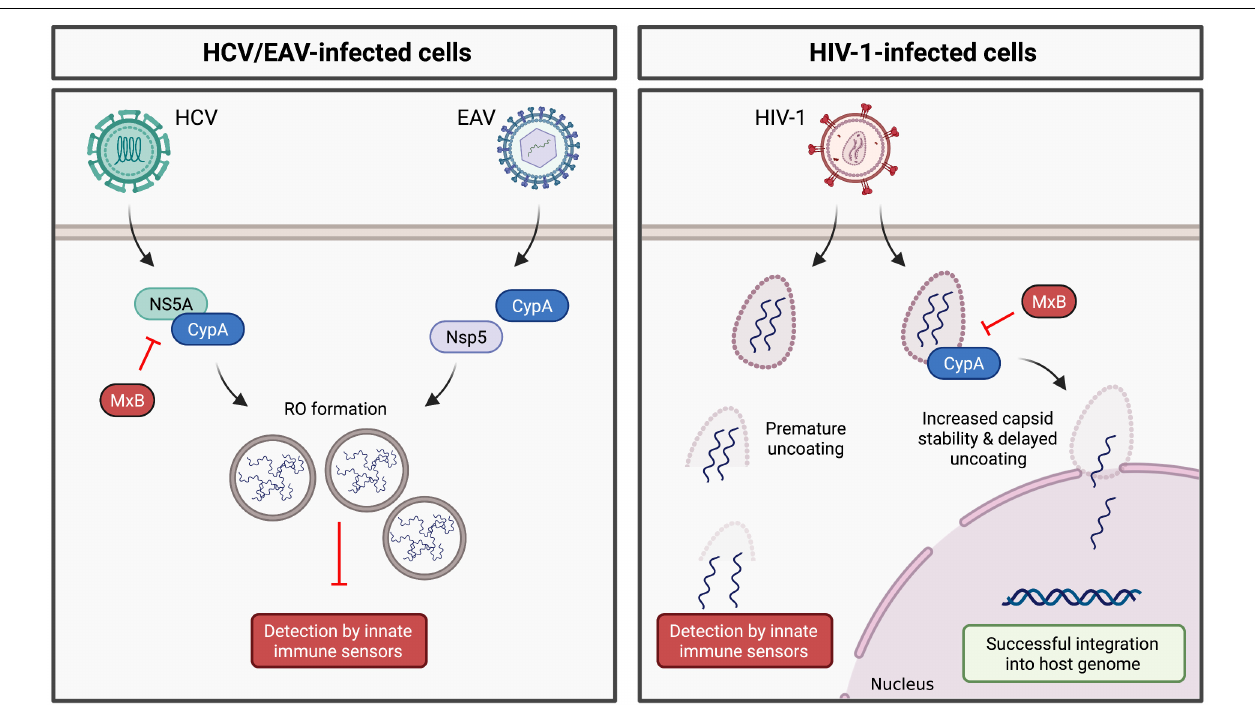
FIGURE 2 | Regulation of viral cloaking by cyclophilin A. (Left panel) CypA modulates the ability of HCV and EAV to form membranous replication organelles, likely through direct or indirect interactions with HCV NS5A or EAV Nsp5, respectively. (Right panel) CypA enhances the stability of the HIV-1 capsid, thus prevent premature cytoplasmic uncoating. MxB inhibits HCV and HIV-1 replication in a CypA-dependent manner, likely disrupting viral